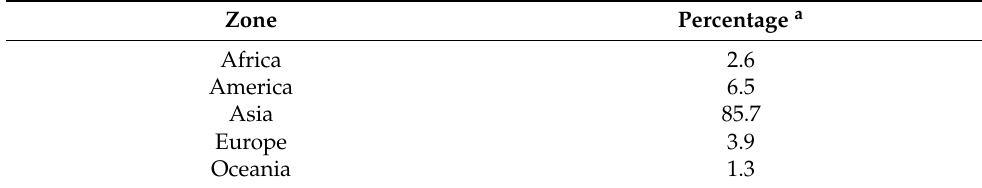
Table 10. Distribution of the papers published in the first six months of the 2021 year.